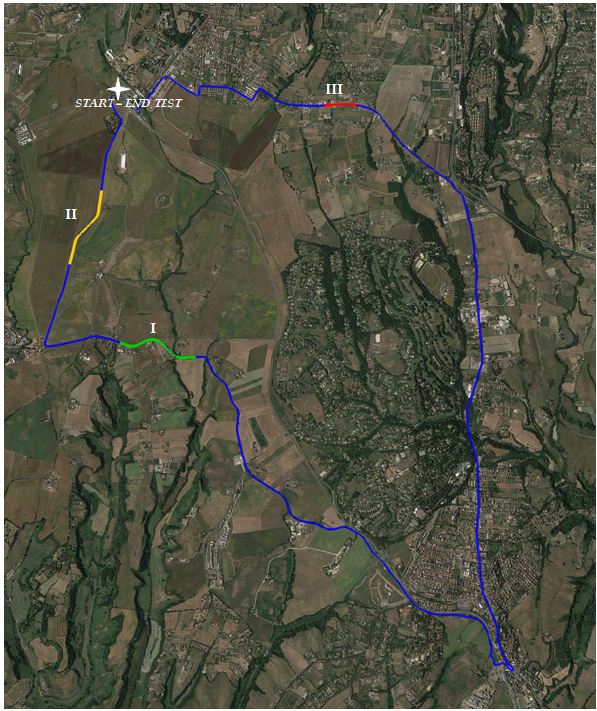
Figure 12. Examined sections for each pavement condition category. Table 8. Characteristics of examined sections.